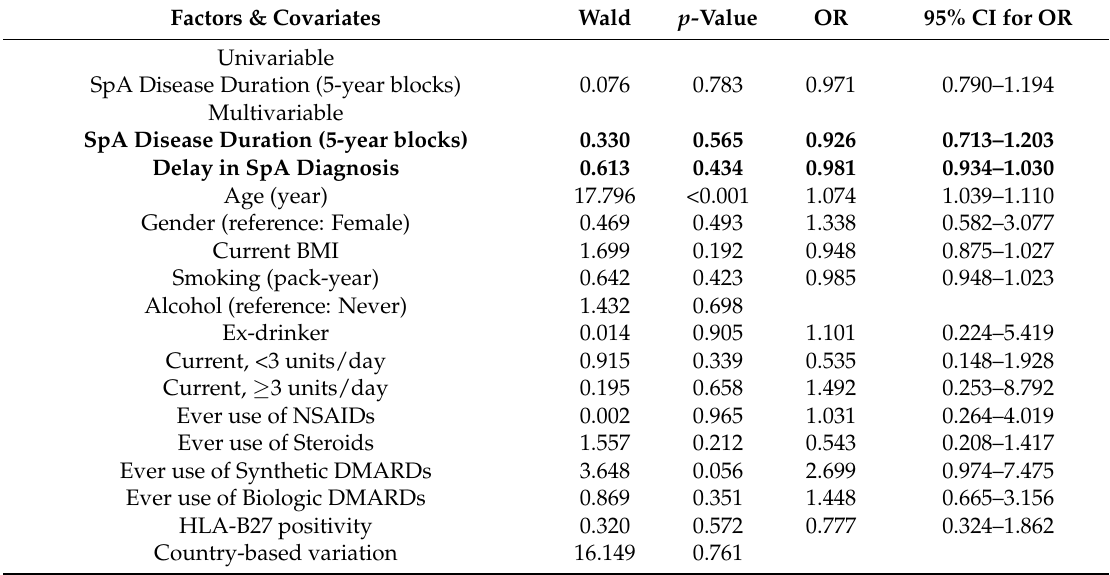
Table 5. Risk of hepatitis C (HCV) infection associated with longer disease duration in participants with